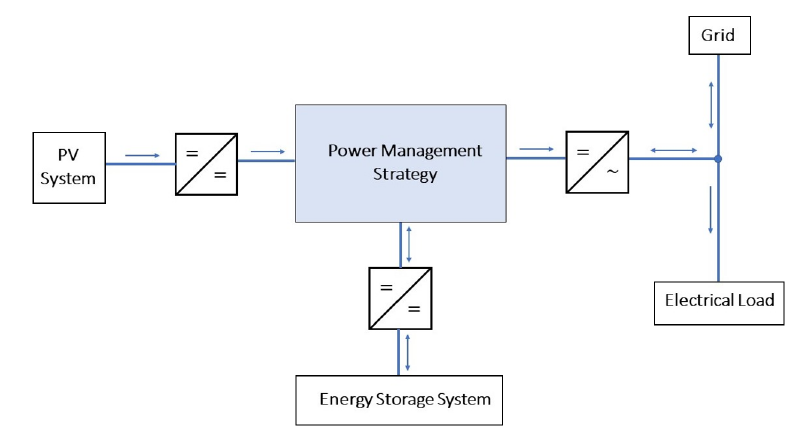
Figure 20. Block diagram of our energy flows management